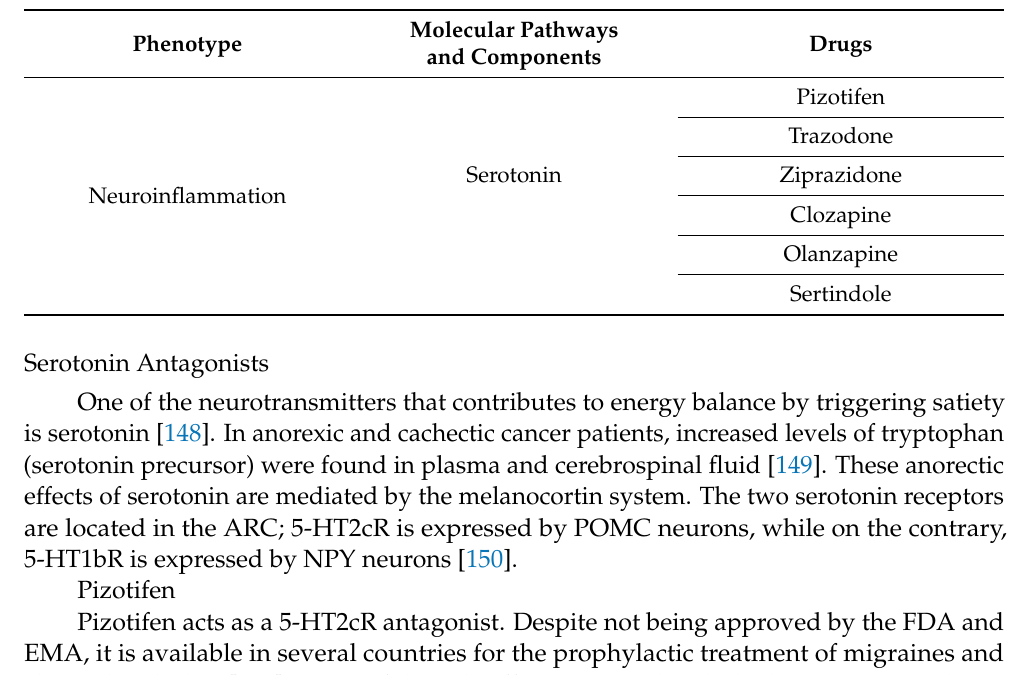
Table 6. Molecular pathways and respective drugs involved in